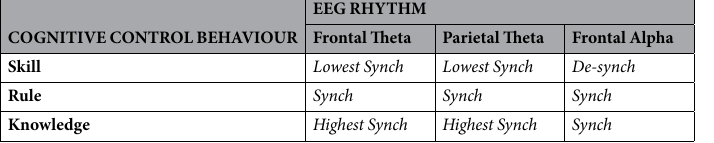
Table 1. Hypothesized SRK characterization by means of the selected EEG rhythms. The SRK behaviours were described in terms of variation from a reference condition: synch – synchronization; desynch –